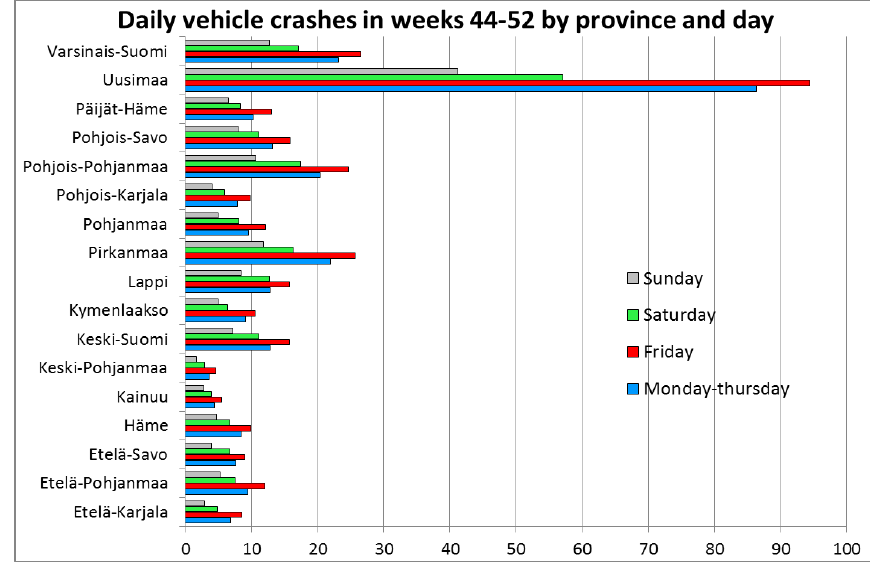
Figure 3. Daily number of crashes by day of the week by region in November and December 2000–2010. Source : study dataset (see Section